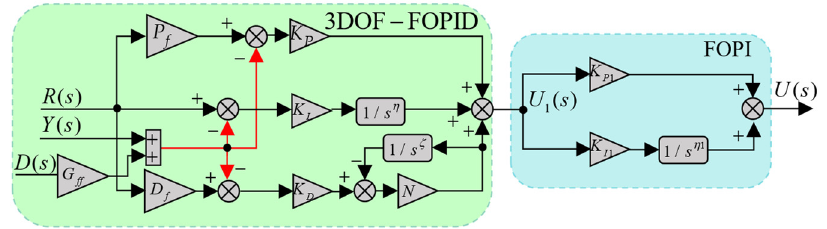
Figure 3. Cascade 3DOF-FOPID-FOPI controller structure block diagram.